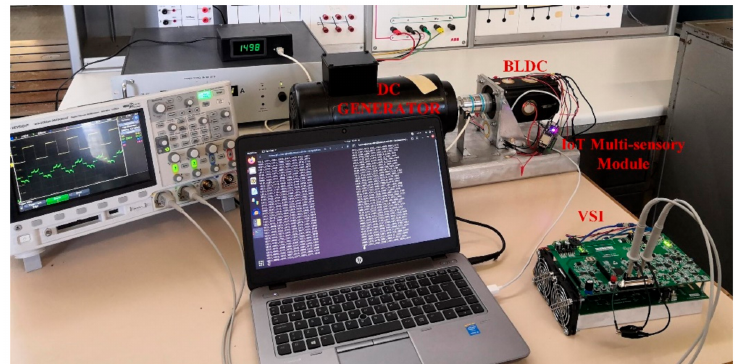
Figure 16. Experimental setup of the developed BLDC motor drive